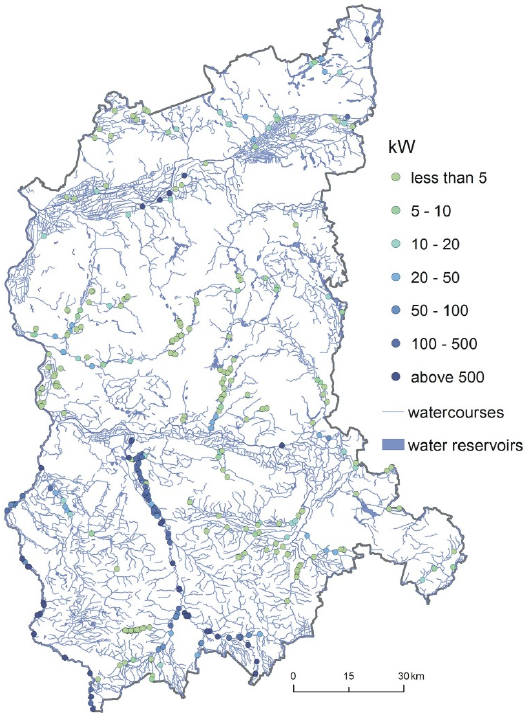
Figure 8. Localization of water dams and power of the potential hydropower plants in the Lubelskie voivodeship (own elaboration).